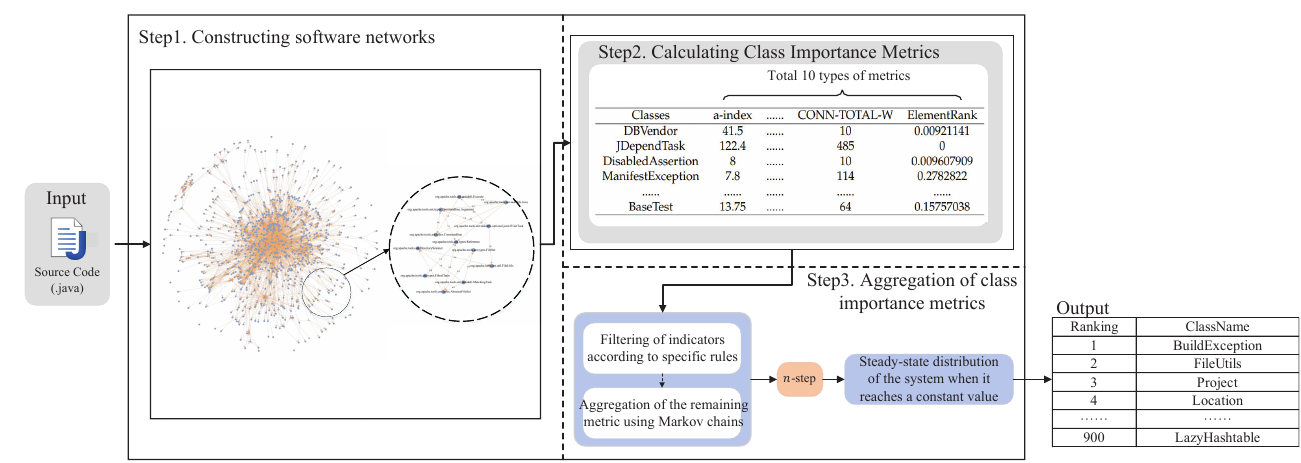
Figure 1. The overall process of the proposed approach.